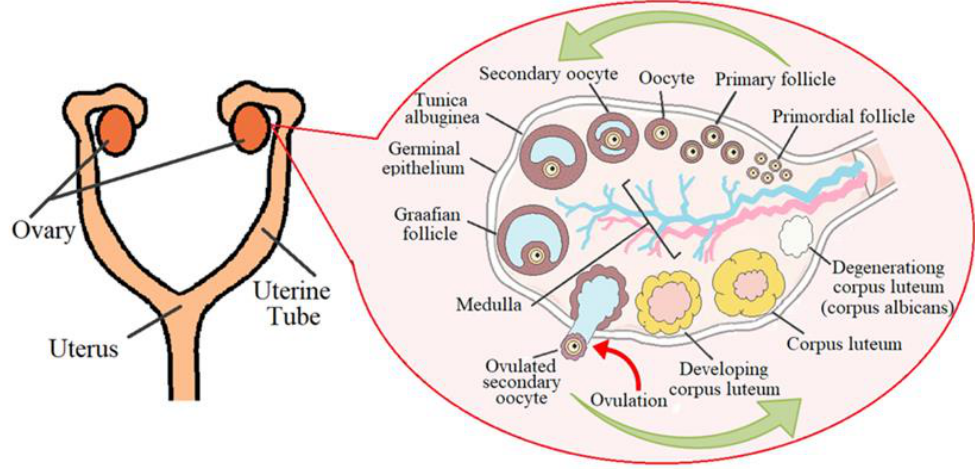
Figure 1. Schematic representation of the ovarian cycle. Adopted from Ref.